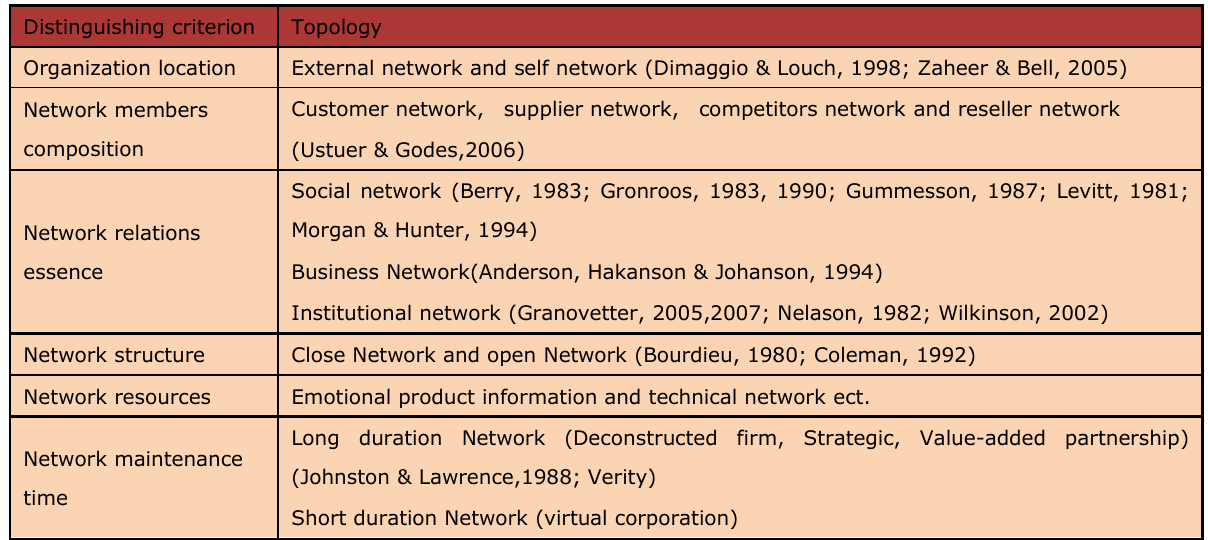
Table 2. Classification of TV media networked marketing network